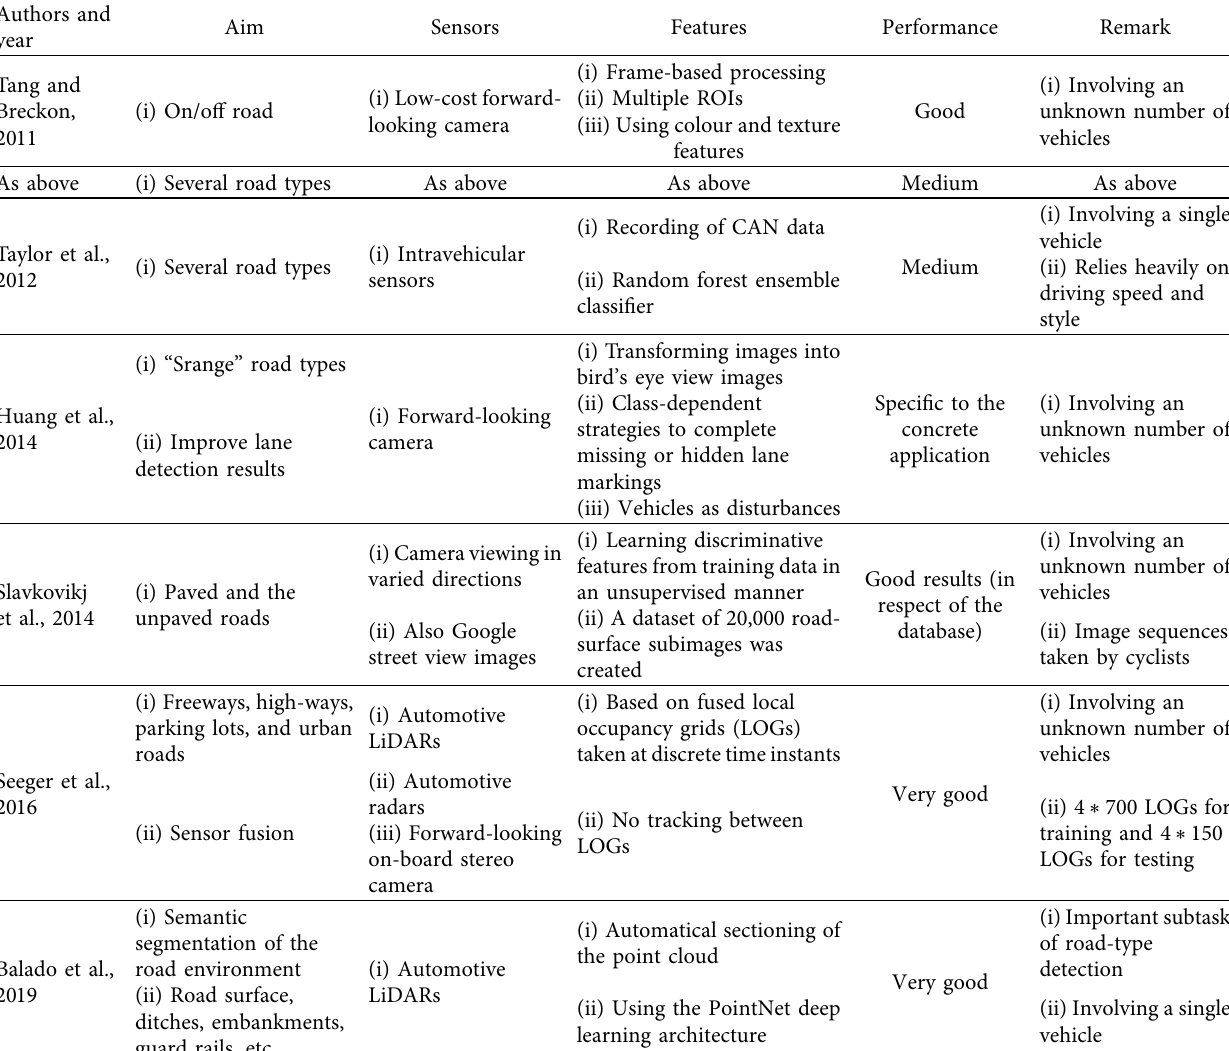
Table 1: Summary of the most important features of the cited research papers on road-type detection methods and systems. Authors